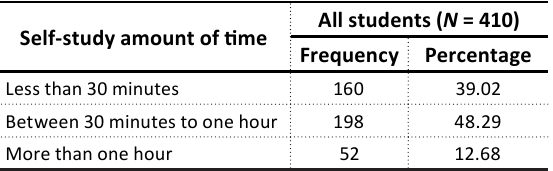
Table 4. The amount of time that students spent on self-study of Mathematics